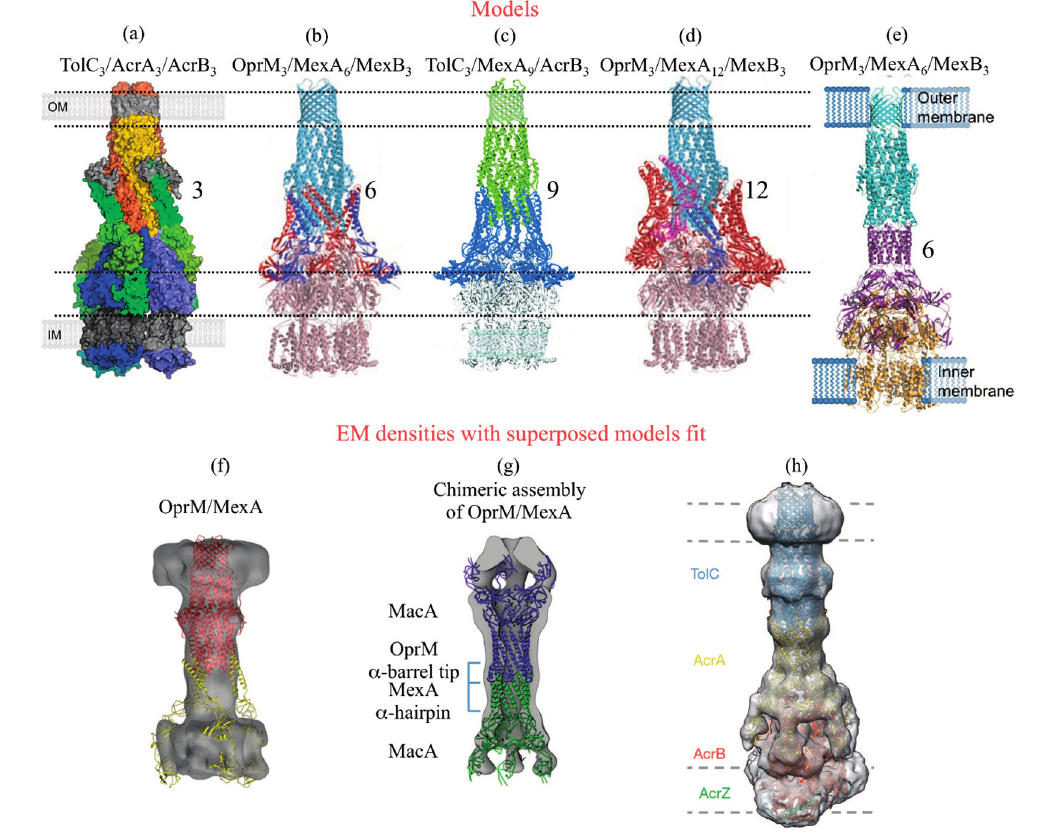
Figure 2. Published models and EM densities of the efflux pump assembly involving OprM or its E. coli counterpart TolC. ( a ) Surface representation of a proposed 3:3:3 assembly model for the TolC-AcrA-AcrB pump from E. coli coloured in orange, green and blue respectively (reproduced with permission from Symmons M.F. et al. , Proceedings of the National Academy of Sciences [55]; published by The National Academy of Sciences, 2009). ( b and d ) Cartoon representations of the respectively proposed 3:6:3 and 3:12:3 assembly models for the MexA-MexB-OprM pump from P. aeruginosa. OprM and MexB are coloured light-blue and pink respectively. Monomers of MexA are in blue, red or magenta (reproduced with permission from Akama H. et al. , Journal of Biological Chemistry [30]; published by The American Society for Biochemistry and Molecular Biology ©2004). ( c ) Cartoon representation of the proposed 3:9:3 assembly model of the chimeric TolC-MexA-AcrB pump, respectively coloured in green, blue and light-blue, based on the fit of their respective 3D structure. (reproduced with permission from Higgins M.K. et al. , Proceedings of the National Academy of Sciences [31] “National Academy of Sciences, U.S.A ©2004”). ( e ) Cartoon representation of a proposed 3:6:3 assembly model for the OprM-MexA-MexB pump from P. aeruginosa , respectively coloured in cyan, purple and orange (reproduced with permission from Xu Y. et al. , Journal of